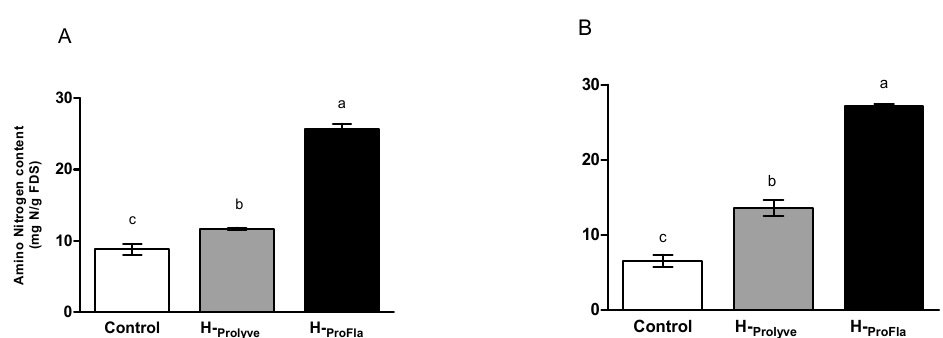
Figure 1. Amino nitrogen content liberated from Porphyra dioica blades ( A ) and protein isolate ( B ), following 2 h hydrolysis at 50 °C with Prolyve® 1000 (H-Prolyve), and 4 h with Prolyve® 1000 plus Flavourzyme® (H-ProFla). Values represent mean ± SD (n = 3). Results are expressed as mg of amino nitrogen per g of freeze-dried sample (mg N/g freeze dried sample (FDS)). Different letters (a, b and c) denote significant differences at p < 0.05 for each sample.